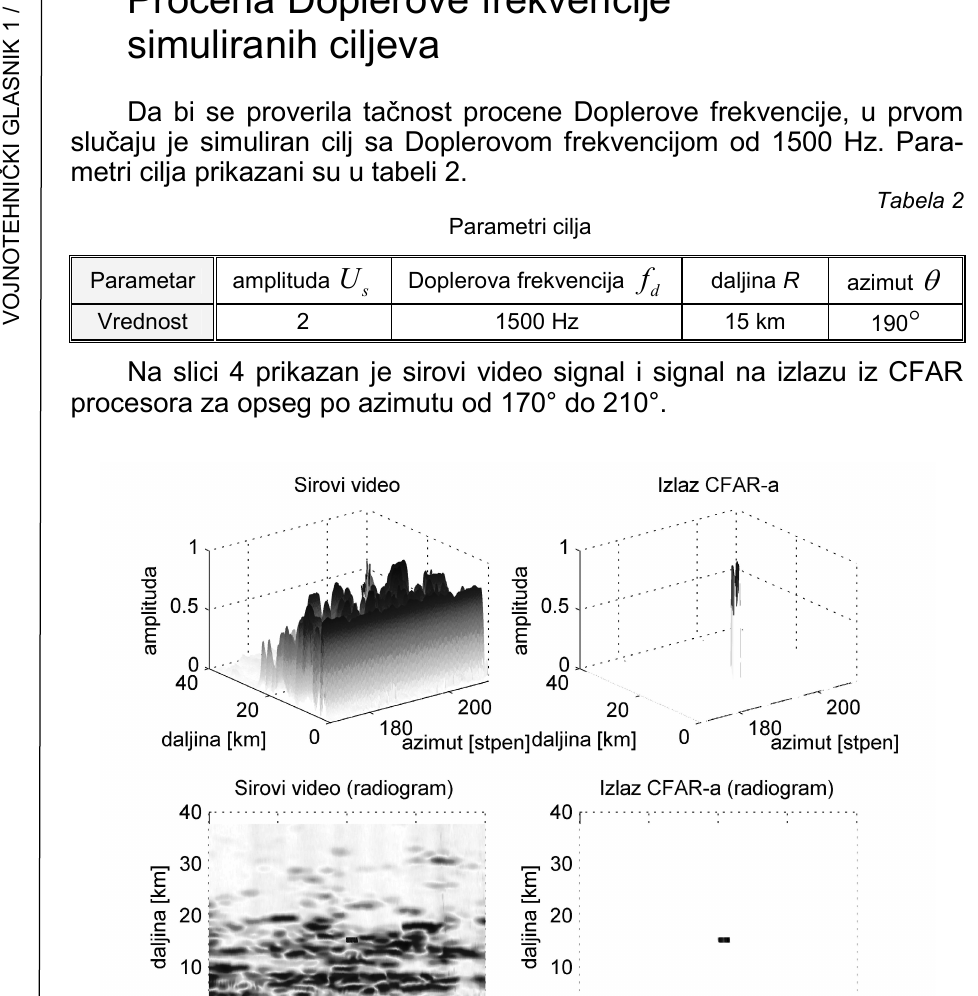
Spektar Doplerove sinusoide dobijen preko modelovanog estimatora radijalne brzine prikazan je u gornjem delu slike 5. Svi spektri Doplerovih sinusoida prora č unati su u 512 ta č aka. Uo č ava se da MUSIC metoda daje precizniju procenu Doplerove frekvencije nego FFT